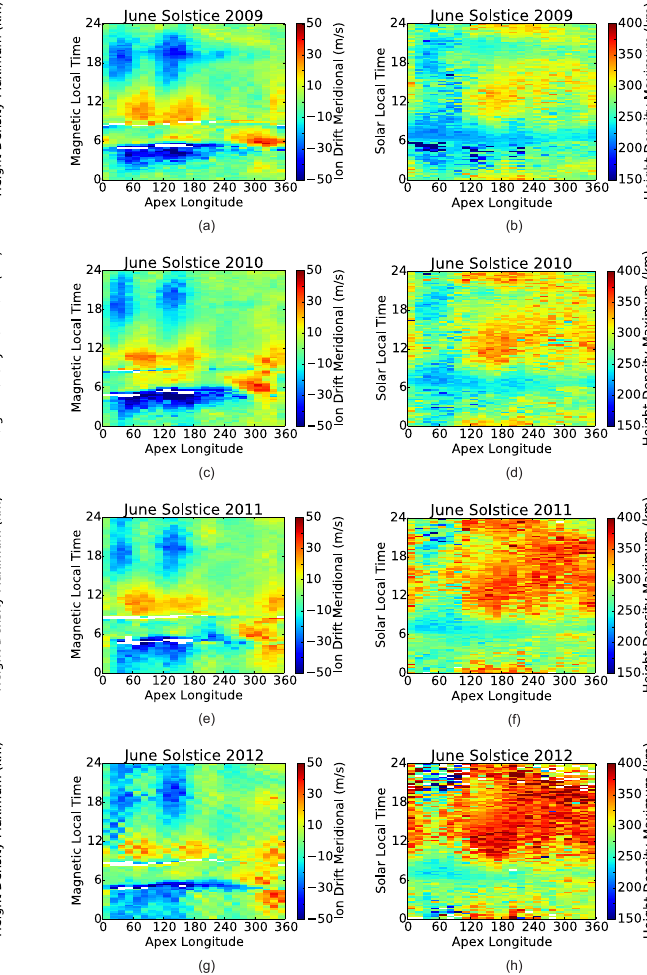
Fig. 7. Left column: median CINDI meridional ion drifts. Right col- umn: median hm F2 near the geomagnetic equator determined by